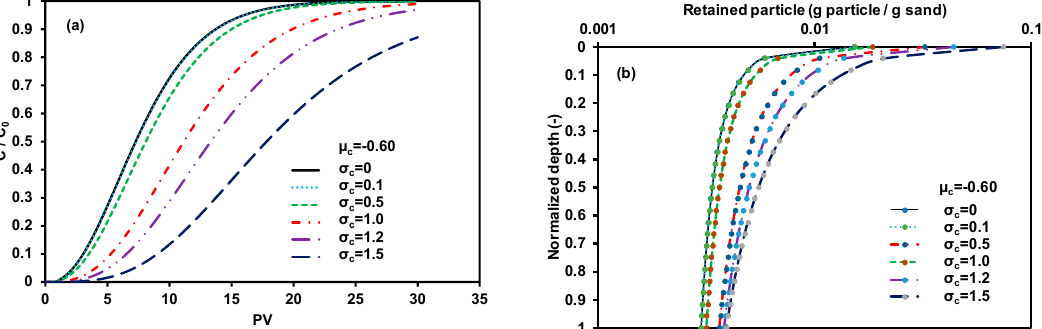
Figure 7. ( a ) Simulated breakthrough curves of contaminant and ( b ) the retention profiles of particles at µ c = − 0.60 and σ c = 0, 0.1, 0.2, 1.0, 1.2, and 1.5.